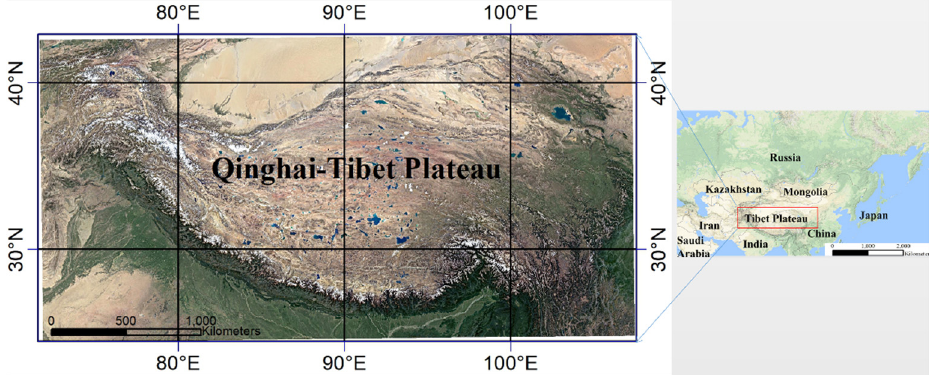
Figure 1. Location and terrain of Qinghai–Tibet Plateau.